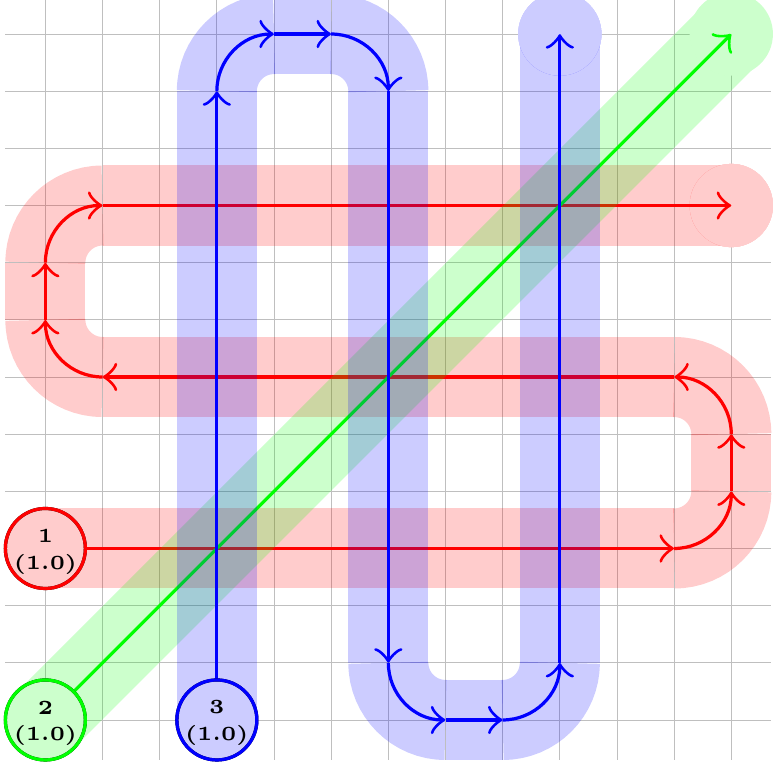
Figure 1. Example base problem instances with 3 robots. Each robot is portrayed with a different color. Circles denote robot starting positions. Circle labels show robot number and speed (in